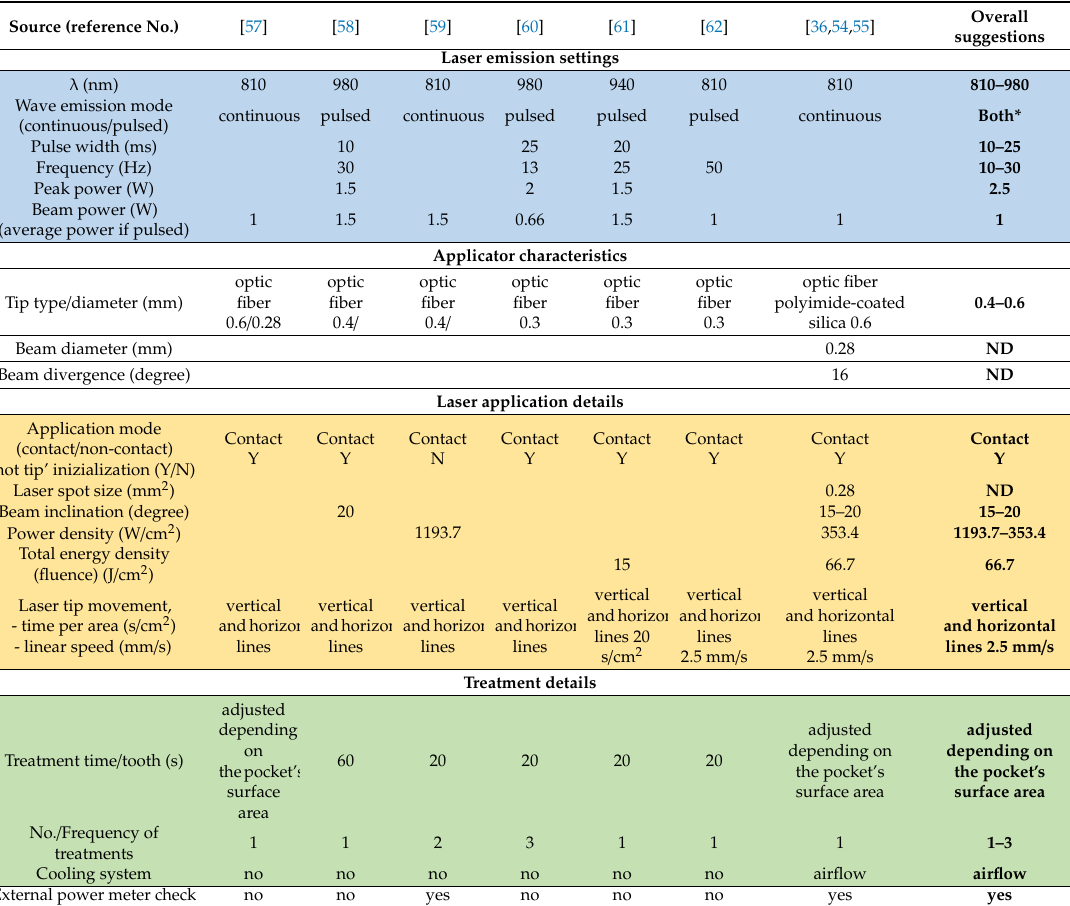
Table 3. Suggested parameters for photoablative diode